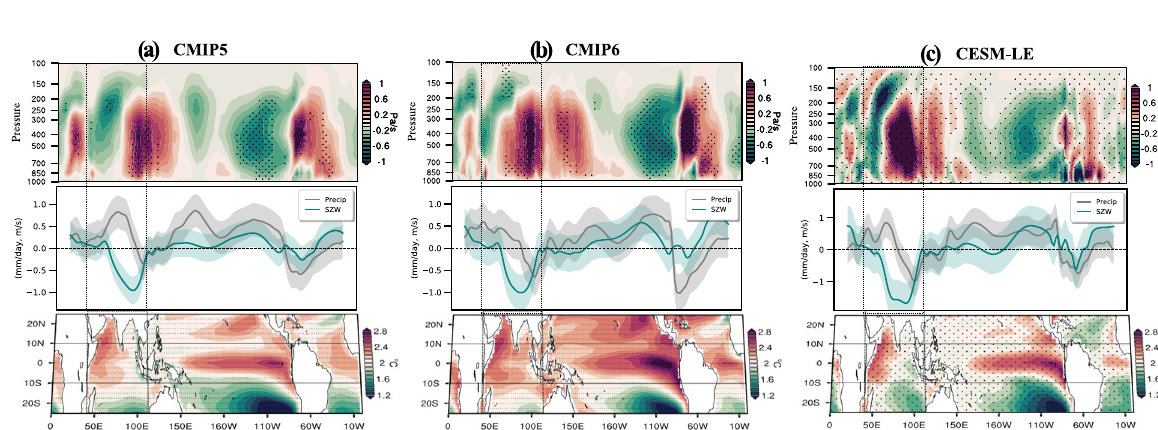
Fig. 2 Projected IWC weakening due to pIOD-like warming pattern and its implication. a The upper plot presents the RCP85 minus historical difference of the meridional average (10 o N: 10 o S) of the ensemble mean vertical velocity (multiplied by the factor 100, Pa/s) at different pressure levels (1000 – 100 hPa). The middle plot in ( a ) concern the meridionally averaged (10 o N: 10 o S) value of precipitation (mm/day, gray) and surface zonal wind (meridional average (5 o N: 5 o S), m/s, green). The shading marks the estimate of ±1 ensemble standard deviation which represents both internal and intermodel variability. The lower plot in ( a ) show the SST change (shading) (RCP85 − Historical period). The black dashes line from top to bottom represents the IO region in each plot (40E:110E and 30S:30N). b Same as in a but for CMIP6 (SSP585 minus Historical). c As in ( a ) but for CESM-LE (RCP85 minus Historical). Stippling in the upper and lower plot in ( a , b ) indicate the areas where at least 70% of CMIP5 and CMIP6 models analyzed in this study exhibit the same sign as the ensemble mean changes. Stippling in the upper and lower plot in ( c ) indicate the regions where the difference between future and historical changes is signi fi cant at 95% con fi dence level based on a two-sample t test on the time series of ensemble